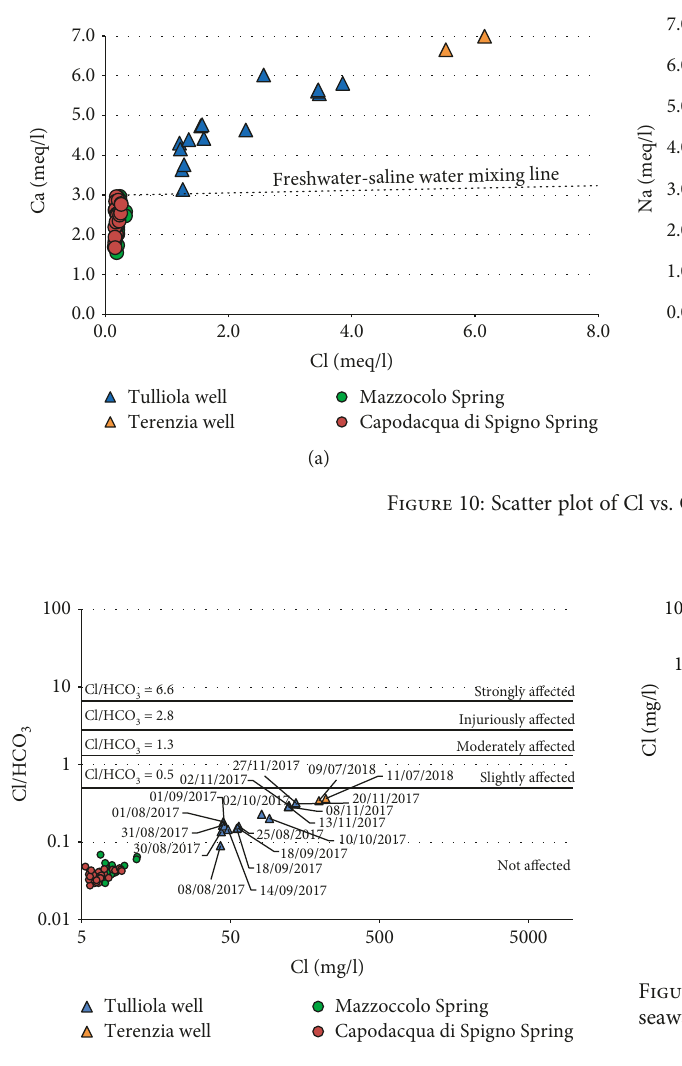
Figure 11: Scatter plot of Cl vs. the Cl/HCO